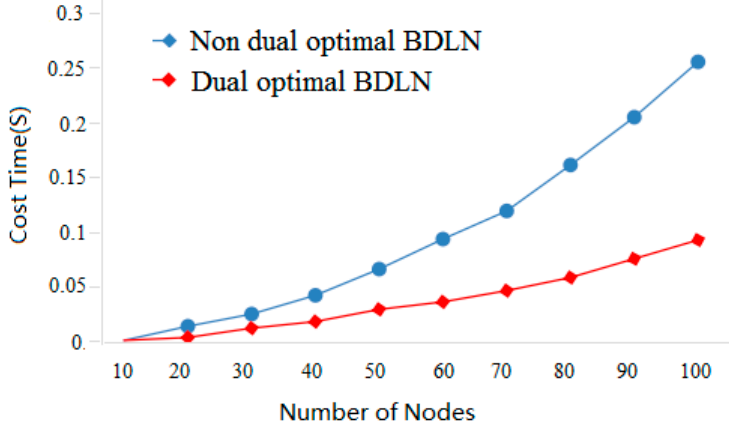
Figure 14. Cost time of optimal routing of dual optimal BDLN and other BDLNs.